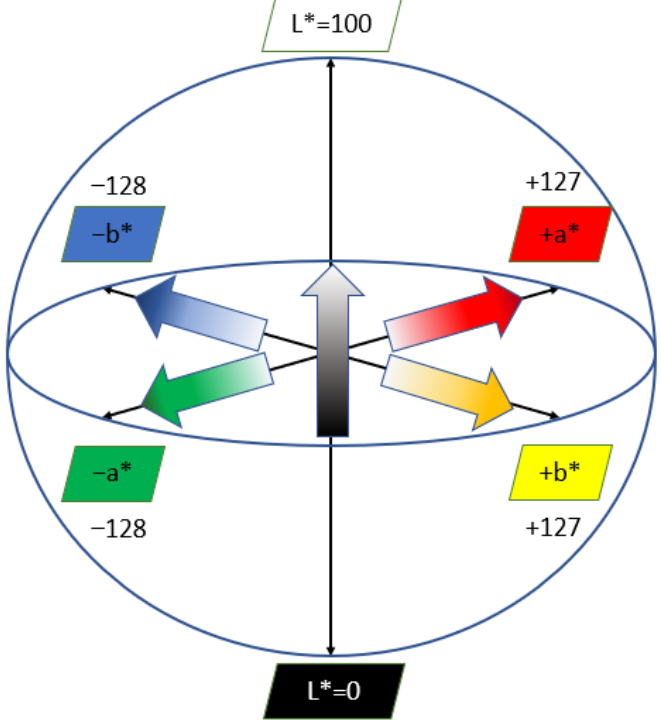
Figure 2. CIELAB color space.